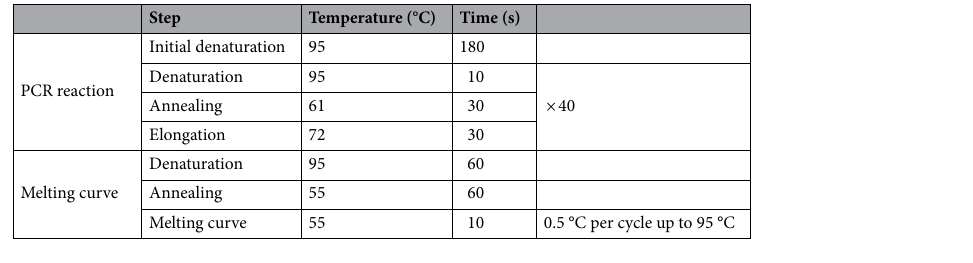
Table 4. qPCR program employed for gene expression